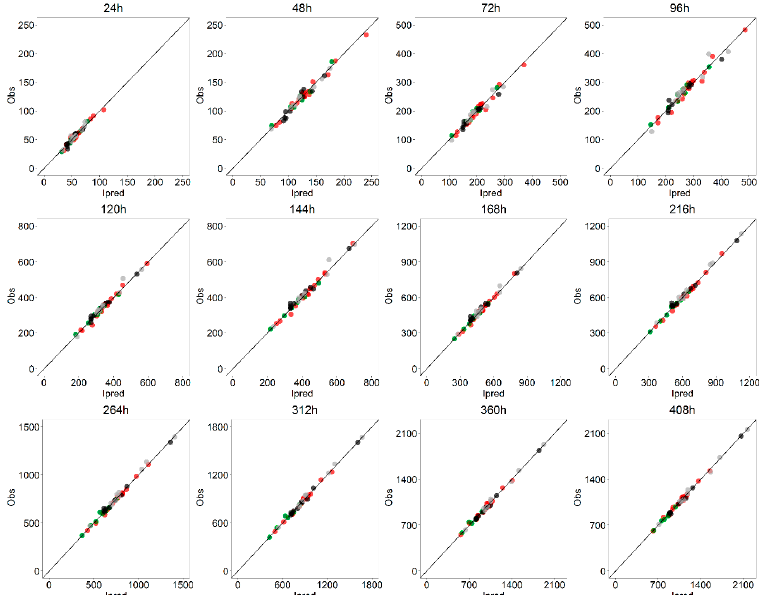
Figure 12. Goodness-of-fit plots for AUC(0-t): Individual observed and model-predicted AUC(0,t) at various sampling times are displayed stratified on dose level by color (green = 125, red = 375, black = 750, grey = 1500 mg).